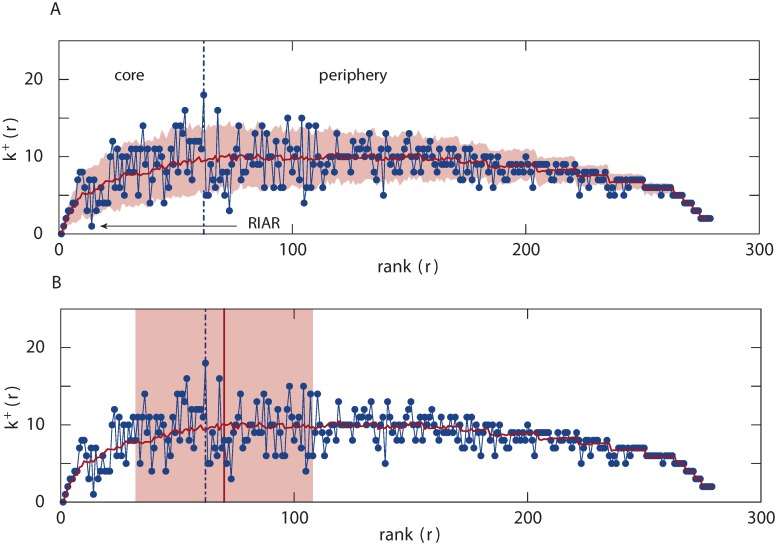
Comparison on the connectivity of the core between the empirical data and the null model for C. elegans.(A) The shaded area marks two standard deviations from the sample mean. Neurone RIAR is found to have an anomalous connectivity with the highest ranked nodes. (B) Comparison on the core size between the empirical data (blue line) and the null model (red line). Similarly, the shaded area shows two standard deviations.